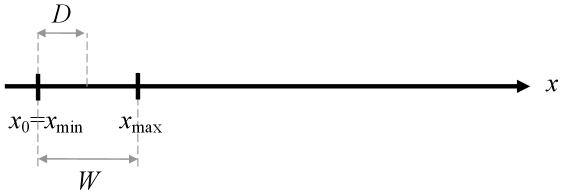
The geometrical minimum of target distance D = ½W.